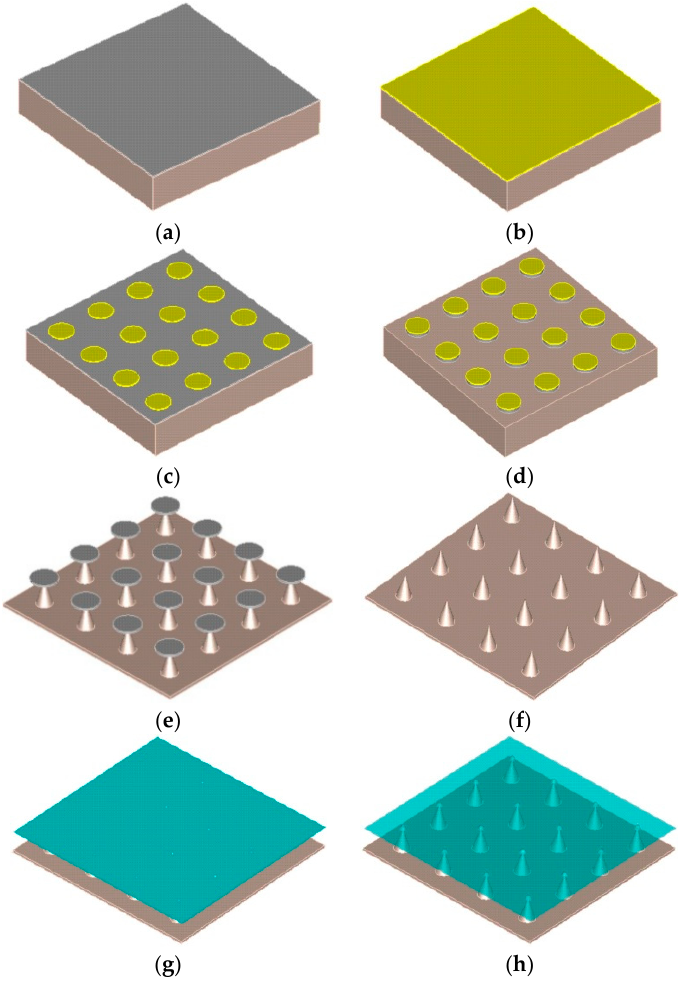
Figure 5. Schematic of the processes flow of transferring the CVD graphene onto the Mo tip array: ( a ) deposition of 300 nm Al; ( b , c ) photoresist patterning by optical lithography; ( d ) ICP etching of Al; ( e ) Mo tip forming ICP etch, ( f ) removal of Al mask; ( g ) PMMA/graphene film transfer; and ( h ) PMMA removal by heating.